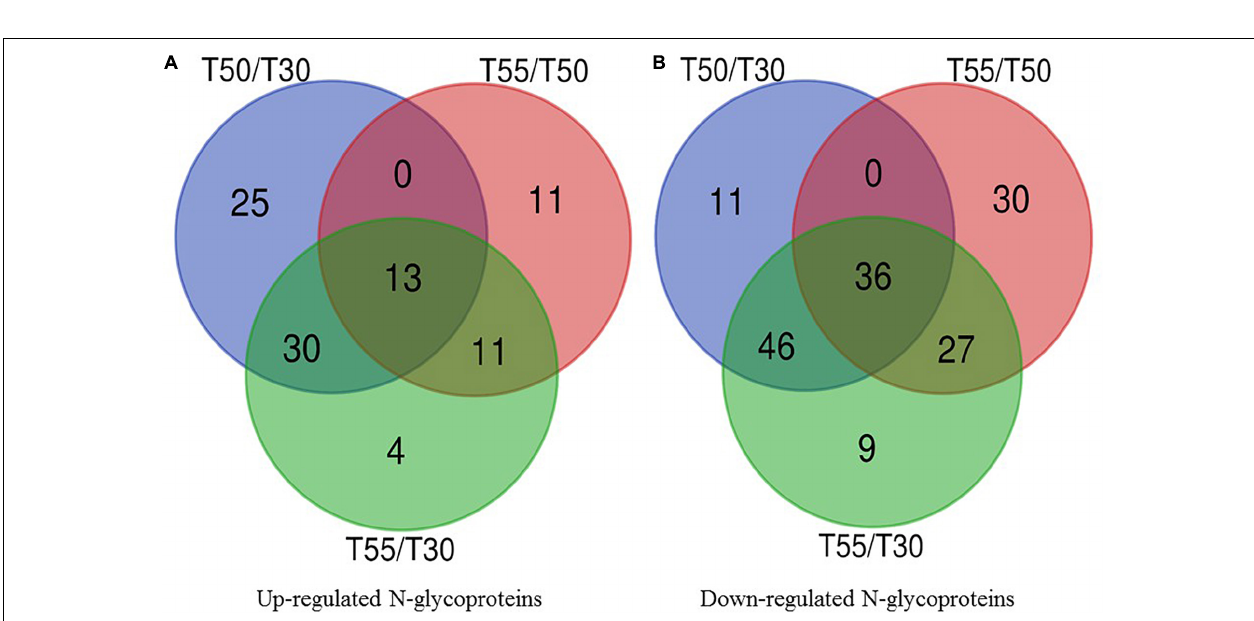
FIGURE 10 | Venn diagram of differentially expressed N-glycoproteins. (A) Venn diagram of up-regulated N-glycoproteins. (B) Venn diagram of down-regulated N-glycoproteins.